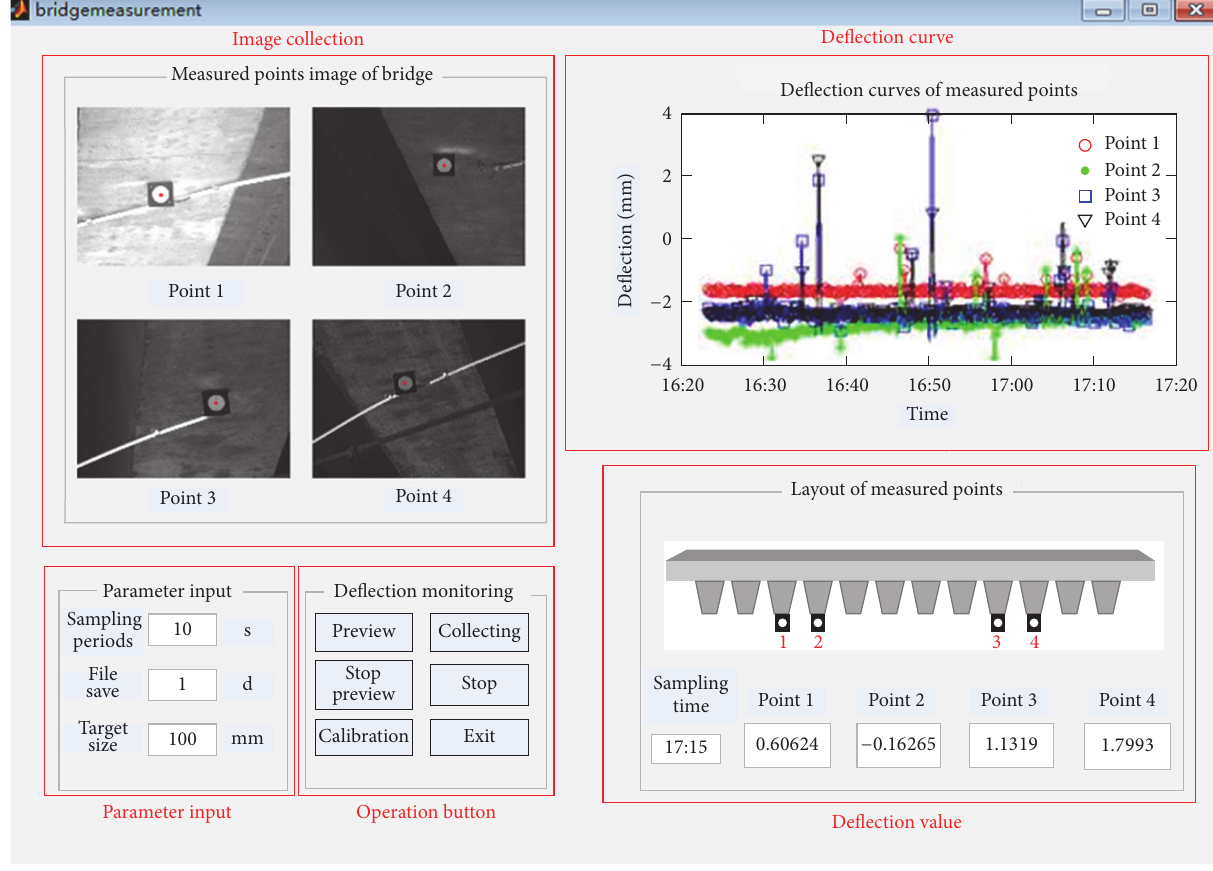
Figure 11: Deflection monitoring software interface for Songjiazhuang cloverleaf junction.